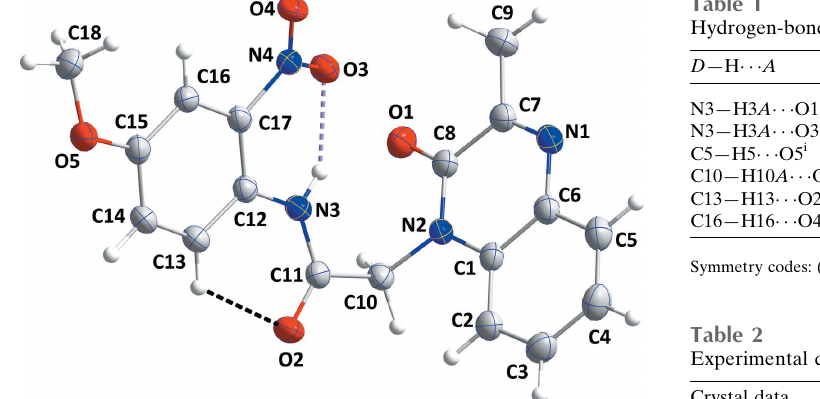
Figure 1 The title molecule showing 50% displacement ellipsoids. The intra- molecular hydrogen bonds are depicted by dashed